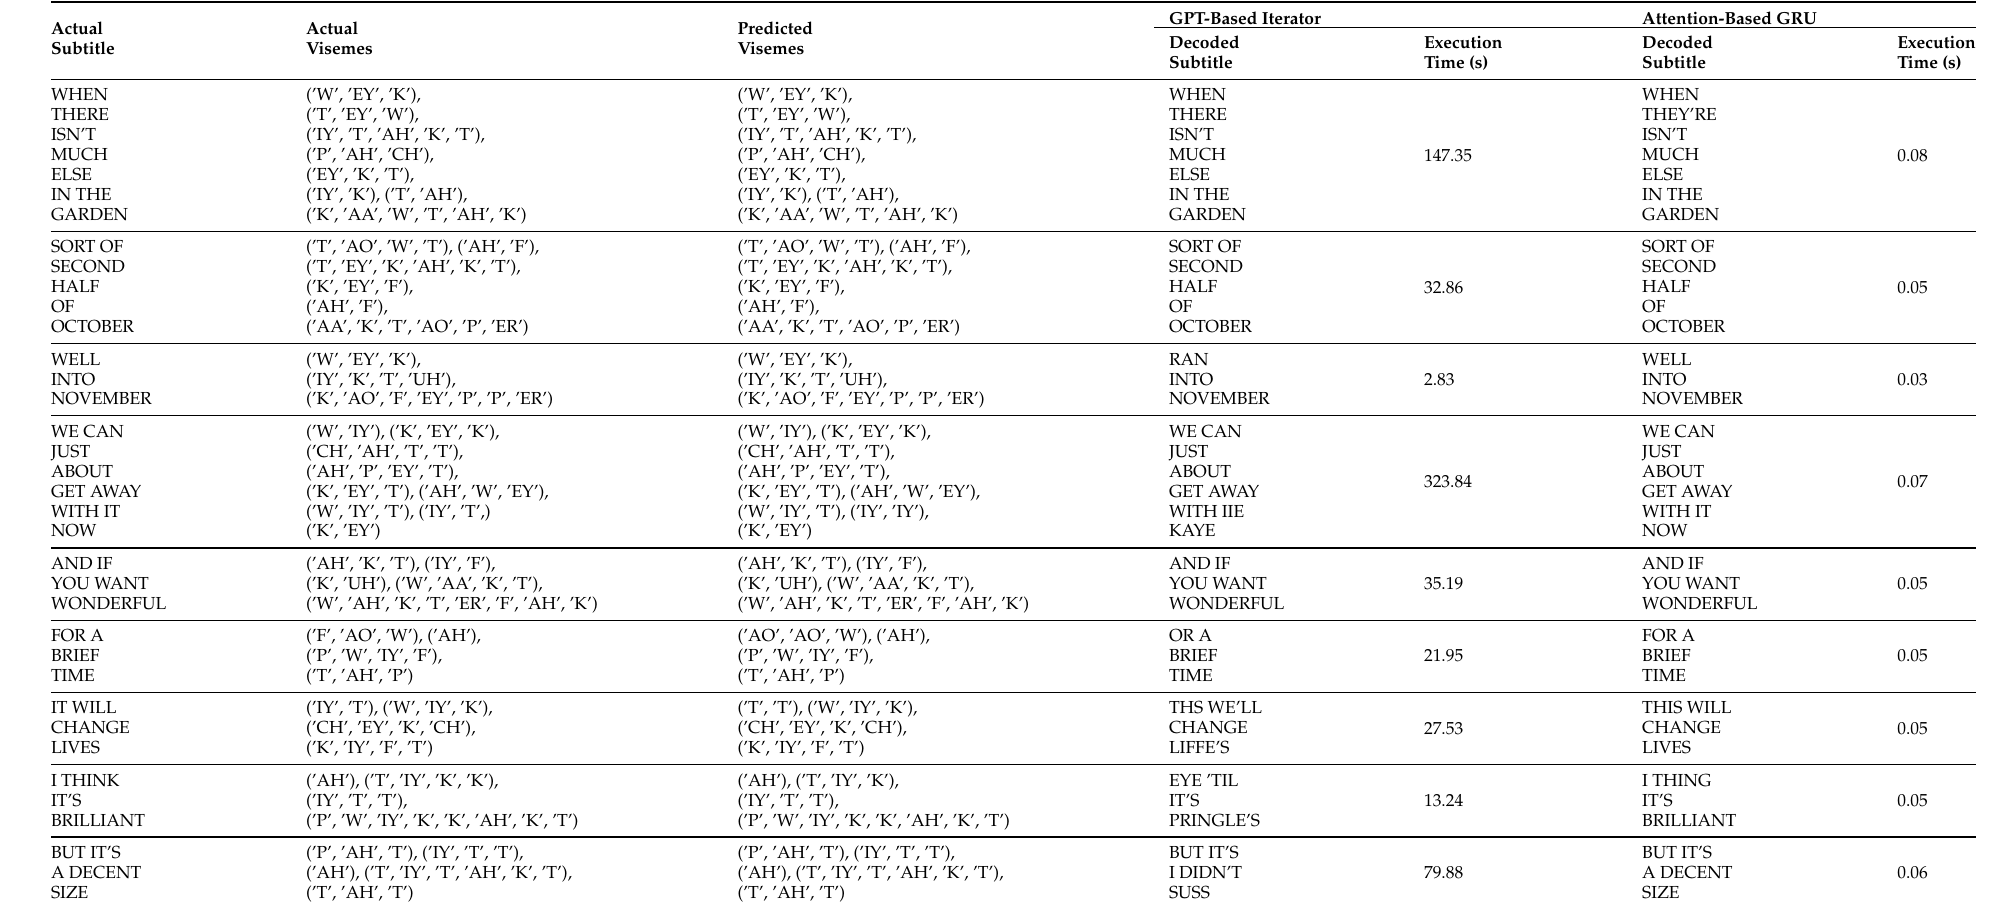
Table 9. Examples of decoded sentences from the two viseme-to-word